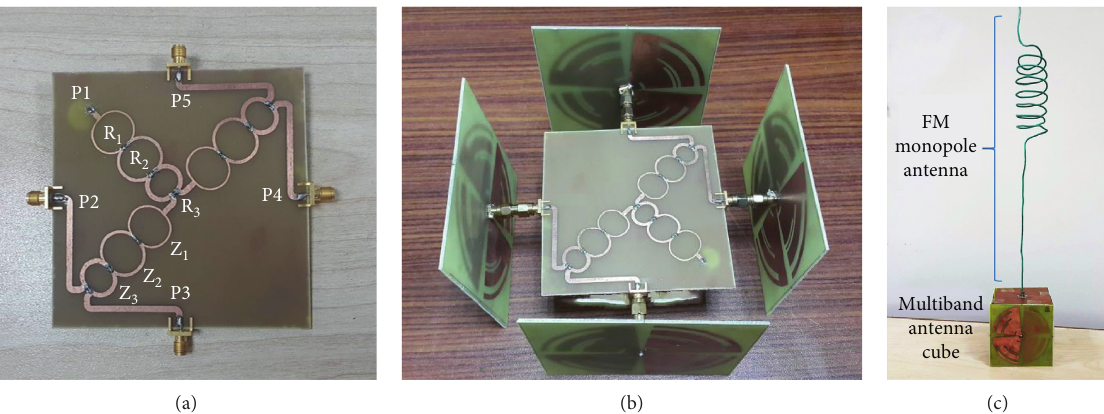
Figure 18: Integration of antennas to form one harvesting node. (a) Power combiner. (b) Combiner with multiband antennas. (c) Proposed 3D rectenna